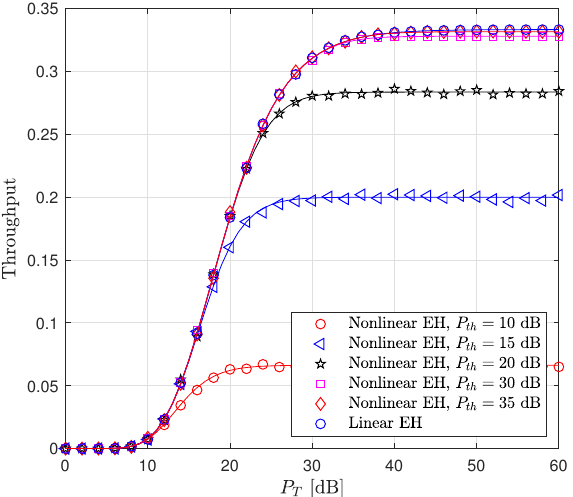
Figure 9. Throughput performance of the WP DH AF relaying system versus P T ( R = 1 bits/s/Hz, d sd = 1).